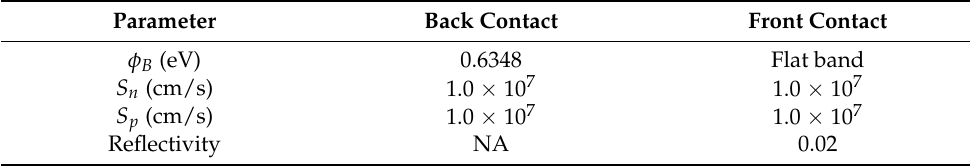
Table A2. Contact Parameters Applied in the Simulation.